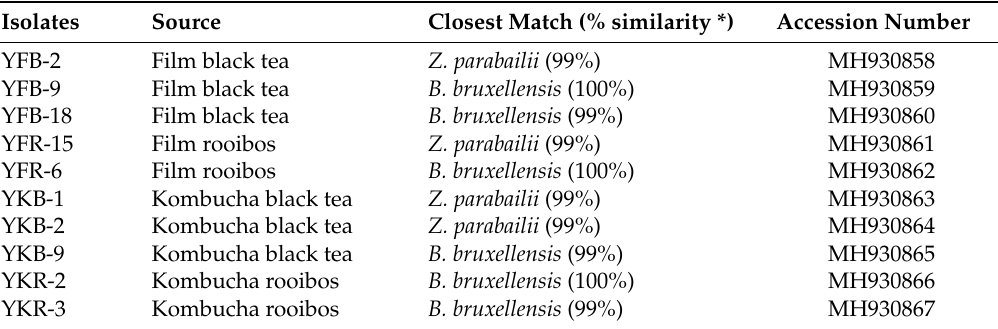
Table 2. Best-match identification of yeast isolates from films and kombucha teas obtained by nBLAST.